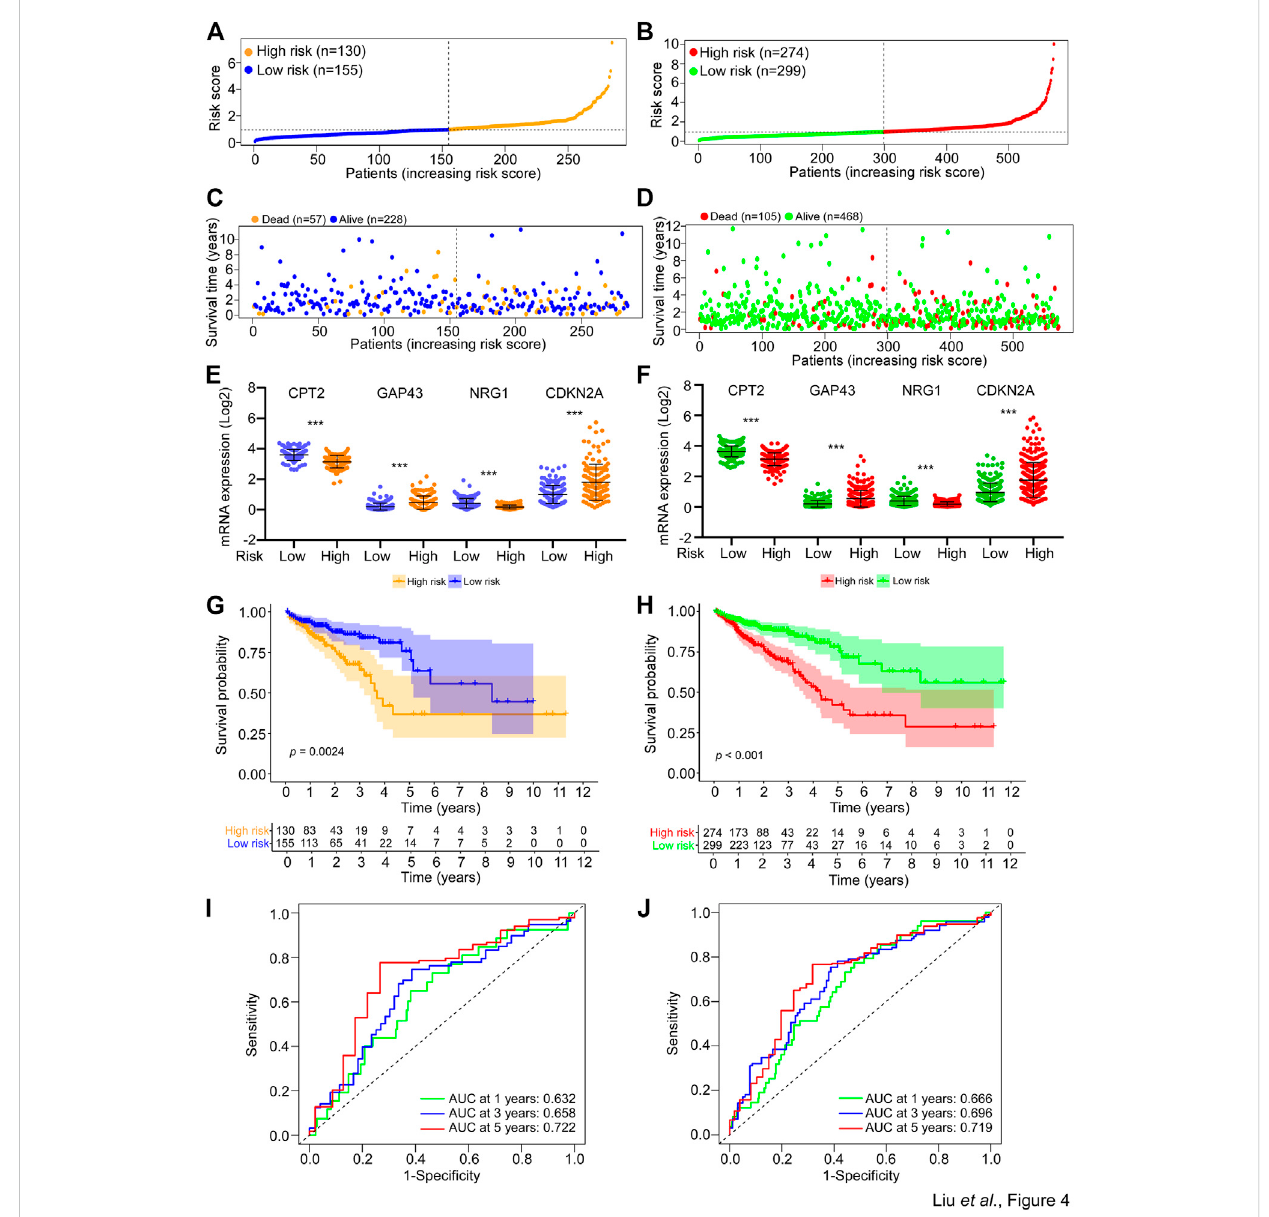
FIGURE 4 Validation of the SGPPGS in the risk test cohort and the whole TCGA cohort. (A,B) The risk score of each sample in the (A) risk test and (B) whole TCGA-CRC cohort was calculated based on the formula for the risk score. The risk score was used to generate the risk curve. (C,D) The risk score and overall survival time of each patient from the (C) risk test (Dead, n = 57; Alive, n = 228) and (D) whole TCGA-CRC cohort (Dead, n = 105; Alive, n = 468) were used to generate a scatterplot with survival status as marked by indicated color. (E,F) The mRNA expression levels of CPT2, GAP43, NRG1, and CDKN2Ainthelow-orhigh-riskgroupofrisktest (E) andwholeTCGA-CRC (F) cohorts. (G,H) Kaplan-Meiercurvesfortheoverallsurvival(OS)ofpatients fromthe (G) risktestand (H) wholeTCGA-CRCcohortwerestrati fi edbyriskcoreobtainedfrom (A,B) .Log-ranktestwasusedtocomparethedifferences between the low- and high-risk groups of the two cohorts. (I,J) The prognostic performance of the risk score from the (I) risk test and the (J) whole TCGA-CRC cohort was veri fi ed by AUC of time-dependent ROC